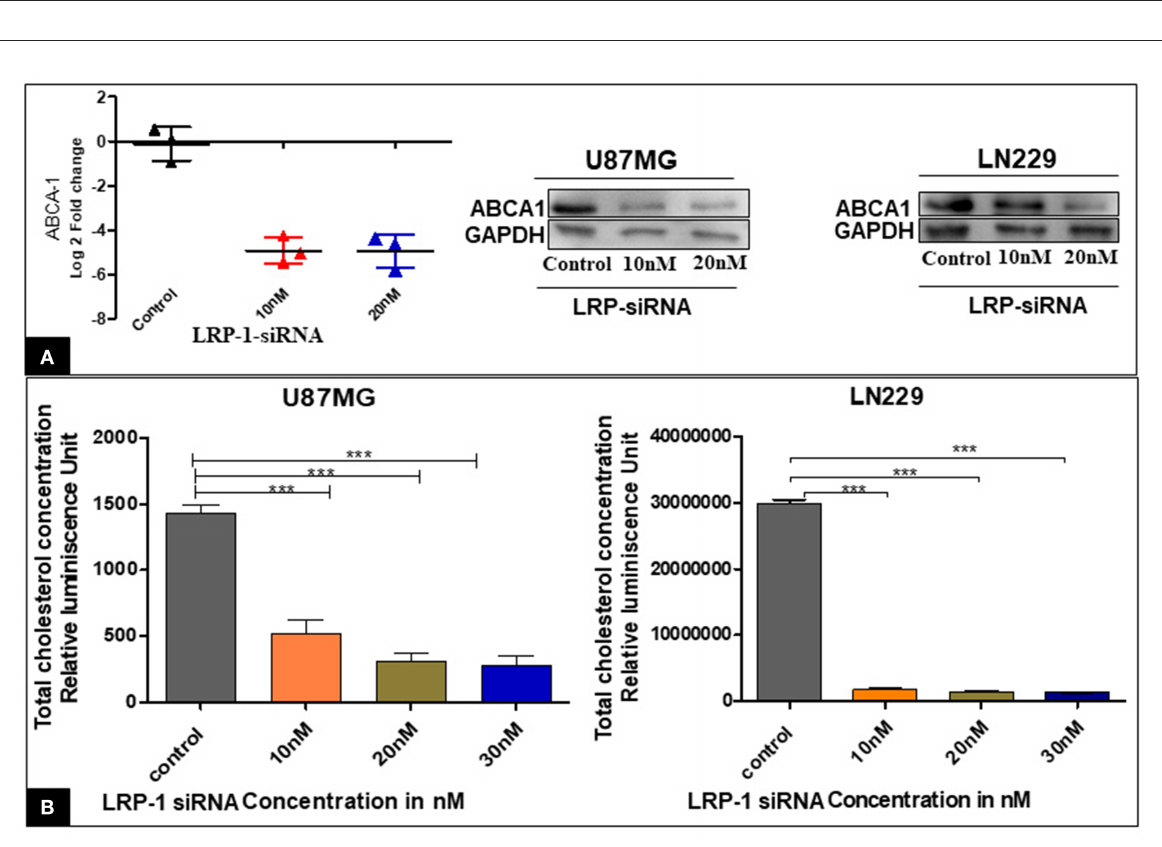
FIGURE5 Effect of LRP-1 silencing on ABCA-1 and the cellular cholesterol level. There was a significant decrease in the level of ABCA-1 at mRNA and in protein level after LRP-1 silencing (A) . There was also a significant decrease in the cellular cholesterol level after LRP-1 knock- down (B) . *** p <